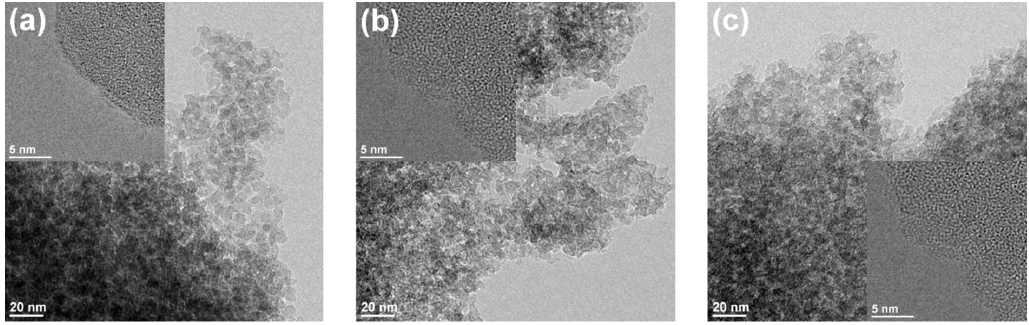
Figure 4. HRTEM images of ( a ) SiO 2 reference, ( b , c ) after 1 and 3 ALD cycles with TMA and H 2 O at 200 °C.